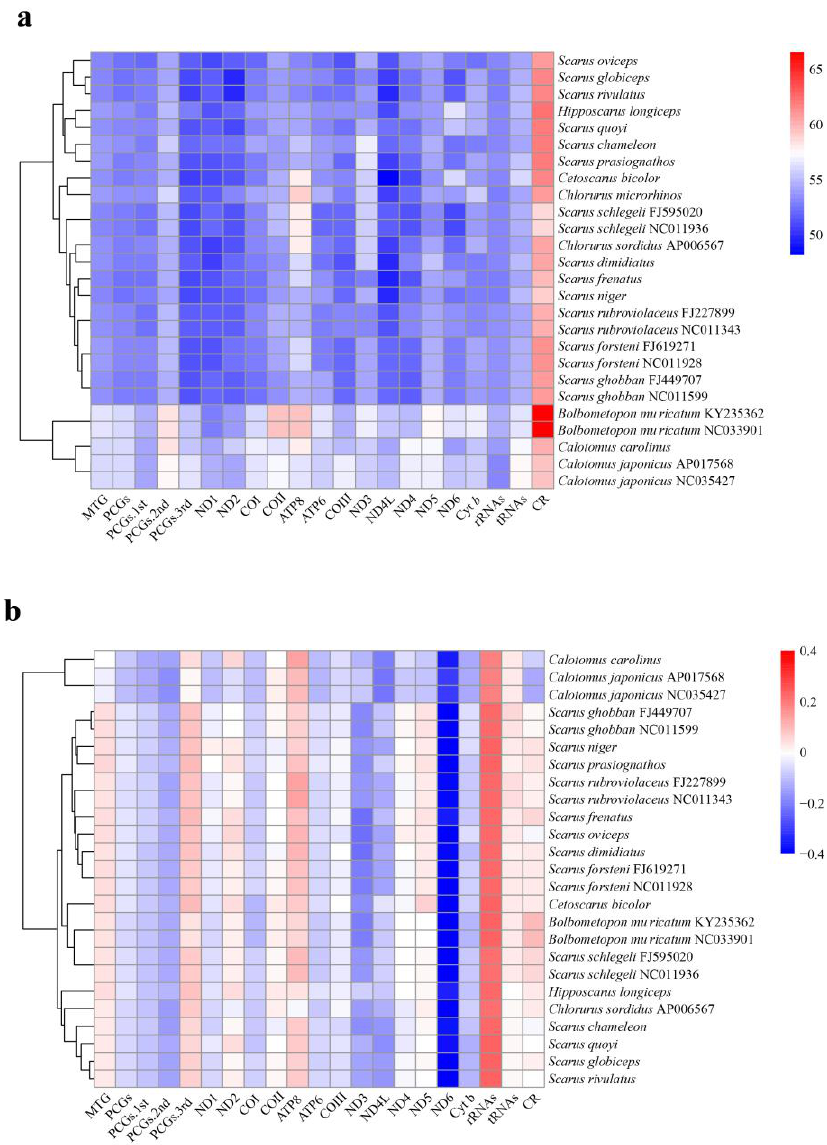
Figure 2. Base composition of various datasets among parrotfish mitogenomes, with hierarchical clustering of parrotfish species (y-axis) based on ( a ) AT content and ( b ) AT